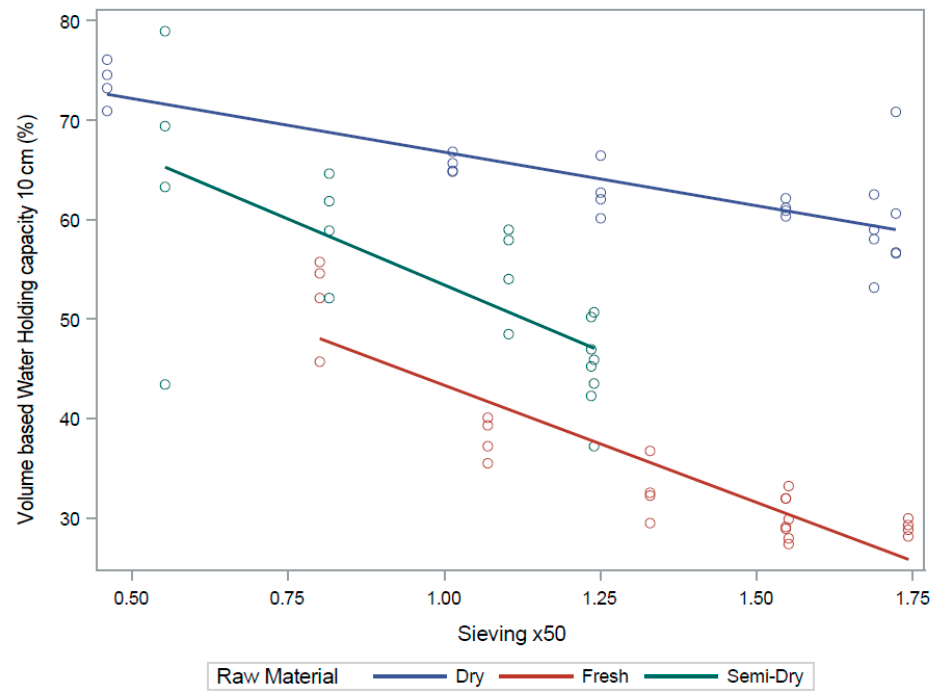
Figure A3. Correlation between WHC − 1 kPa (volume based) and X-50.